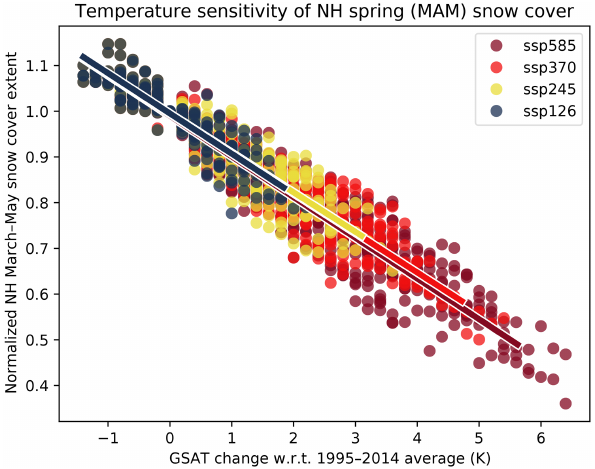
Figure 9. Spring (March to May) NH snow cover extent against GSAT (relative to the 1995–2014 average) for the CMIP6 Tier 1 scenarios (SSP1-2.6, SSP2-4.5, SSP3-7.0, and SSP5-8.5), with lin- ear regressions. Each data point represents the average snow extent from one CMIP6 simulation (first ensemble member for each avail- able model). The average is taken over all pentads from the given simulation which fall into the given temperature bin.